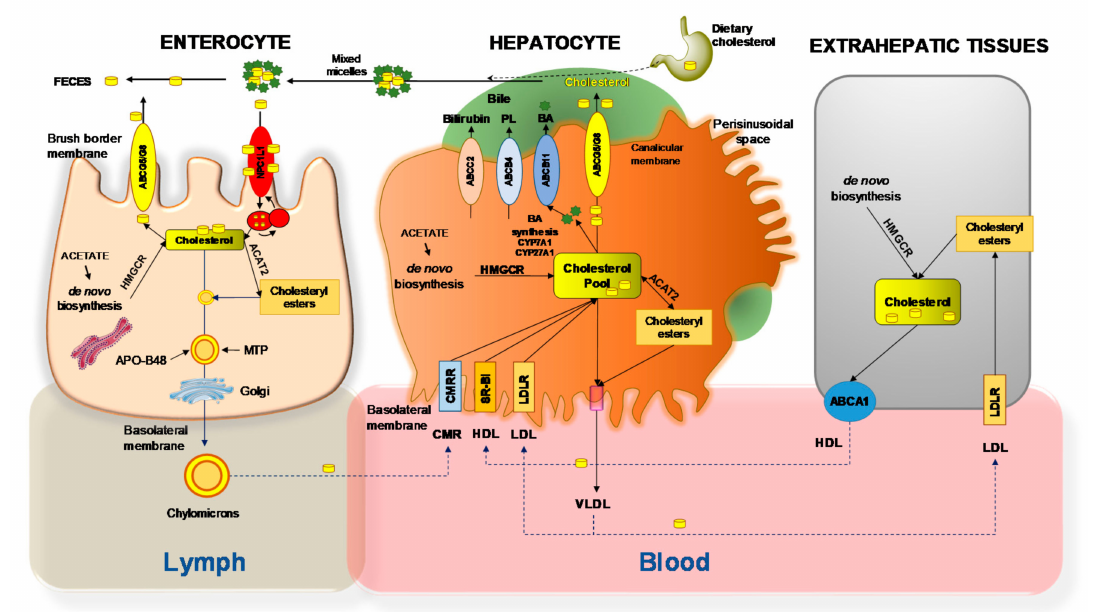
Figure 2. Net cholesterol flow through the body. In the small intestinal lumen, micellar solubilization facilitates the diffusion of sterols through enterocyte. Mixed micelles (Bile acids (BA) and cholesterol) increase the uptake of cholesterol via the Niemann–Pick C1 like 1 (NPC1L1) protein, a sterol influx transporter. The transporter ABCG5/G8 (brush border membrane) promotes active efflux of cholesterol from the enterocyte back into the intestinal lumen for fecal excretion. The combined regulation of NPC1L1 and ABCG5/G8 modulates the amount of cholesterol reaching the lymph from the intestine. Cholesterol (either absorbed or newly synthesized molecules from acetate by 3-hydroxy-3-methylglutaryl-CoA reductase [HMGCoAR]) are esterified to fatty acids by acyl-CoA:cholesterol acyltransferase isoform 2 (ACAT2), to form cholesteryl esters. This pool of lipids contributes to the assembly of chylomicrons, which are enriched with the apolipoprotein B-48 (apoB-48) and require microsomal triglyceride transfer protein (MTTP). The core of chylomicrons secreted in lymph contains triglycerides and cholesteryl esters. The surface contains phospholipids, unesterified cholesterol, and apolipoproteins such as apoB-48, apoA-I, and apoA-IV [24,25]. The hepatic uptake of cholesterol involves the scavenger receptor class B type I (SR-BI) for high-density lipoprotein (HDL), the low-density lipoprotein (LDL) receptor (LDLR) for LDL, and the chylomicron remnant receptor (CMRR) for chylomicron remnants (CMR). Biosynthesis of hepatic cholesterol (CH) from acetate requires the rate-limiting enzyme 3-hydroxy-3-methylglutaryl-coenzyme A reductase (HMGCR). Most of the cholesterol undergoes the synthesis of BA involving two rate-limiting enzymes in the classical pathway (cholesterol 7a-hydroxylase, CYP7A1) and the alternative pathway (sterol 27-hydroxylase, CYP27A1). Some cholesterol is esterified by acyl-coenzyme A: cholesterol acyltransferase isoform 2 (ACAT2). This step provides lipid droplets serving for storage within the hepatocytes. Some of the cholesterol is arranged with the very-low-density lipoprotein (VLDL), secreted into blood. Cholesterol secretion across the canalicular membrane of hepatocytes into the bile canaliculus requires the specific ATP-binding cassette transporter ABCG5/G8. This process is paralleled by secretion of the two other lipids acting as cholesterol transporters in bile, i.e., BA via ABCB11, and phospholipids (PL) via ABCB4. In extrahepatic tissues VLDL delivers cholesterol across LDL and LDLR, while cholesterol is excreted via the transporter ABCA1 and formation of HDL. Abbreviations: CYP7A1, cholesterol 7- α ; CYP27A1, sterol 27-hydroxylase; RER, rough endoplasmic reticulum. Adapted from D. Q-H. Wang et al.